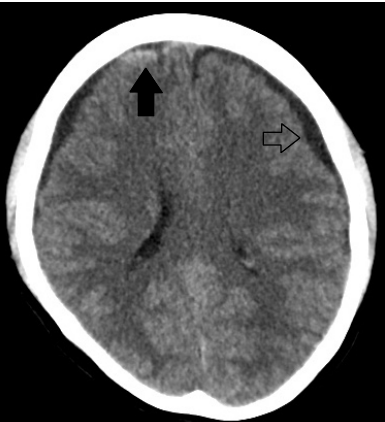
Figure1:NonintravenouscontrastenhancedbrainCTdemonstratesbilateralCSF-densitysubduralhygromas(leftsubduralhygromalabelled with an open arrow) and a hyperdense acute right frontal subdural hematoma (solid arrow).